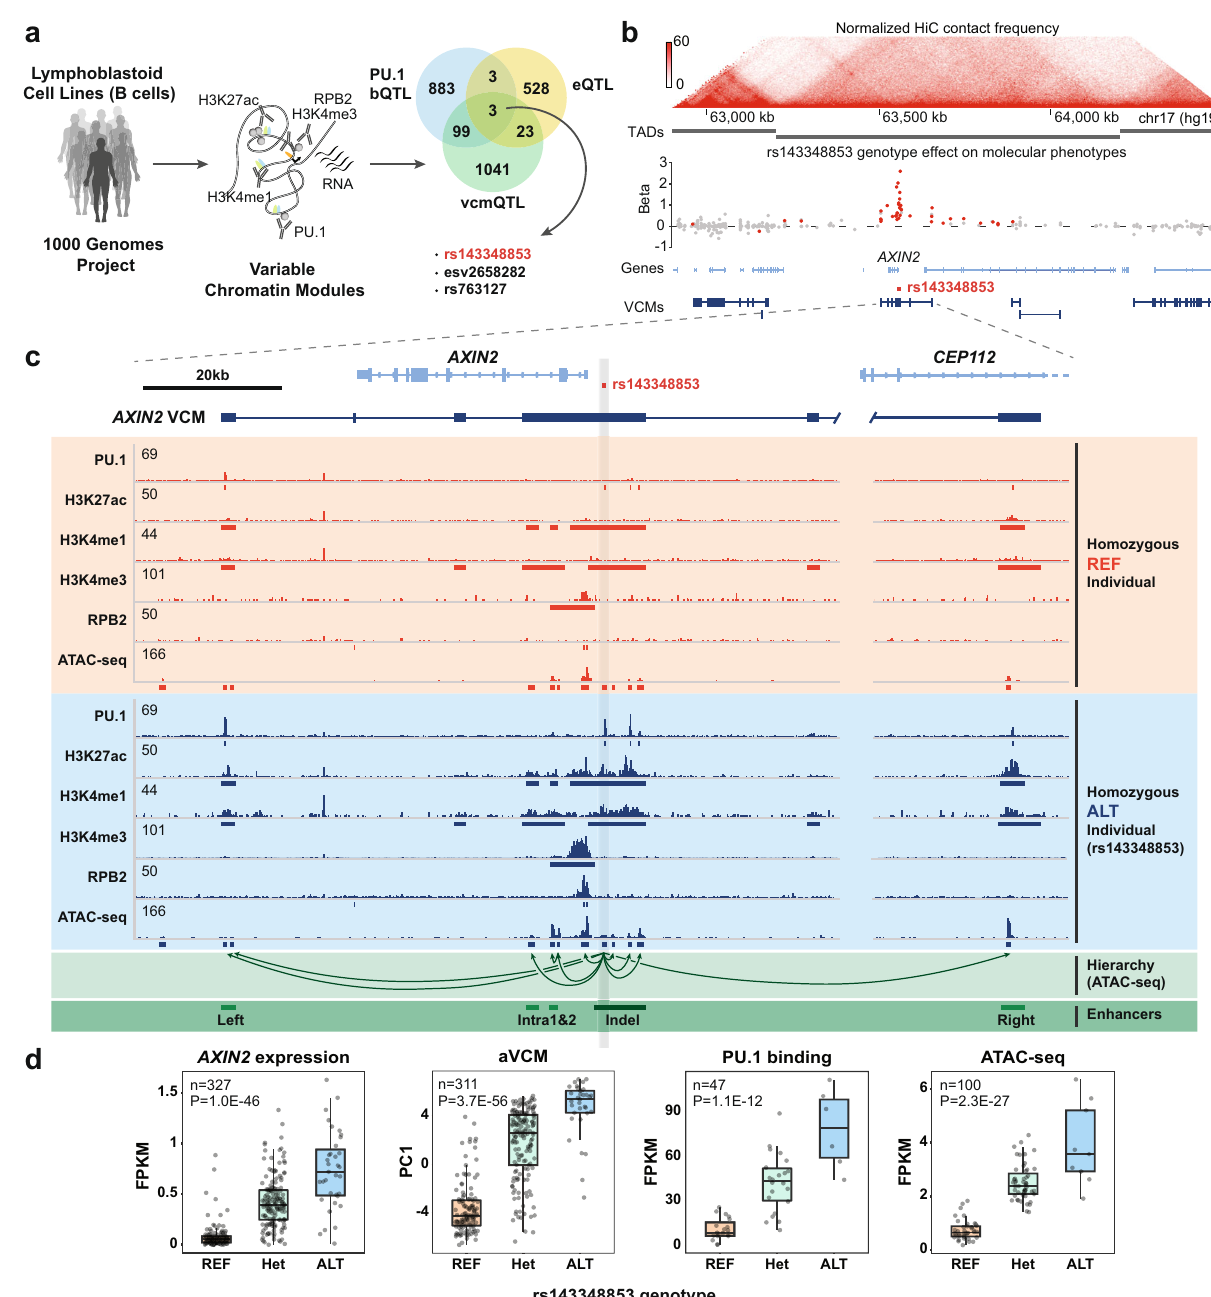
Fig. 1 rs143348853 indel activates the AXIN2 VCM in LCLs. a Work fl ow to evaluate impactful genetic variants using the VCM concept and Venn diagram of the signi fi cant variants considering an FDR ≤ 10% for VCM activity (vcmQTL), PU.1 binding (bQTL) and gene expression (eQTL). b (Top) Genomic view centered on the AXIN2 -containing TAD using the 3D Genome Browser 110 showing GM12878 HiC interactions from Rao et al., 2014 53 and GM12878 TADs from Beekman et al., 2018 72 . (Bottom) Beta values representing the genetic effect of rs143348853 on different molecular phenotypes (PU.1, H3K27ac, H3K4me1, H3K4me3, RPB2 ChIP-seq, and ATAC-seq signals; FDR < 0.05 values are colored in red) and consensus VCMs. See Supplementary Fig. 1b for beta values for each molecular phenotype. c IGV 111 view of the AXIN2 VCM region showing the consensus AXIN2 VCM and pro fi les for the studied molecular phenotypes from two different individual LCLs representing the rs143348853 homozygous REF and ALT genotypes. Meta peaks are displayed below each track. The shown regulatory hierarchy across the ATAC-seq peaks (visualized as unidirectional arrows) was inferred from the directed acyclic graph information from Kumasaka et al., 2018 16 . Finally, the fi ve principal AXIN2 LCL enhancer regions are annotated in green according to H3K4me1 and H3K27ac overlap, while the hypothesized “ lead ” enhancer is marked in dark green. d Boxplots showing different molecular phenotypes for each rs143348853 genotype in LCLs: AXIN2 mRNA expression, the activity of the AXIN2 VCM as measured by the fi rst principal component analysis value (PC1) on all correlated histone marks embedded in the AXIN2 VCM, and PU.1 binding (peak id 1036) and ATAC-seq signal (peak id 254430) for the rs143348853-overlapping peaks. n indicates the number of considered individual LCL samples and P indicates the p- value from a linear regression model. Boxes indicate the IQR (25 – 75%) and the box center indicates the median. Whiskers represent the minimum or maximum values of no further than 1.5 times the IQR for both the top and bottom of the